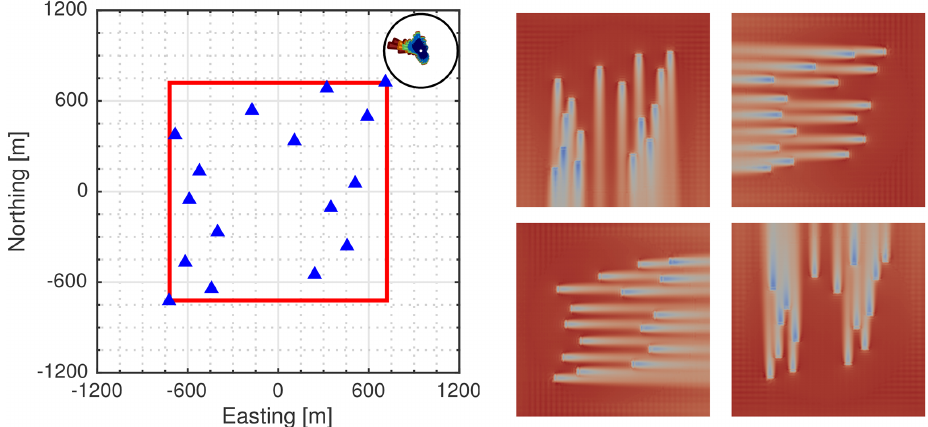
Figure 10. Optimal layout (top left) and flow fields resulting from a full AEP optimization using data from the M2 mast at NWTC. Differ- ences in both wind speed and wind direction are accounted for in the optimization, and the wind rose used is shown in the top right corner of the layout plot. In the top left panel, the site boundary is shown by a solid red line and turbine locations are denoted by blue triangles. Flow fields are shown for inflow winds from the north (top left), east (top right), south (bottom right), and west (bottom